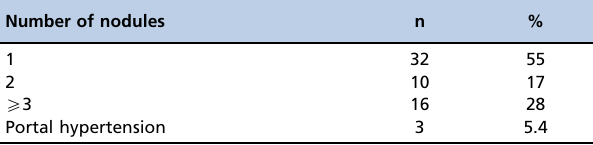
Table 3 - Imaging-based diagnosis of hepatocellular carcinoma (US* + CT** and/or MRI***) in the patients with nonalcoholic steatohepatitis